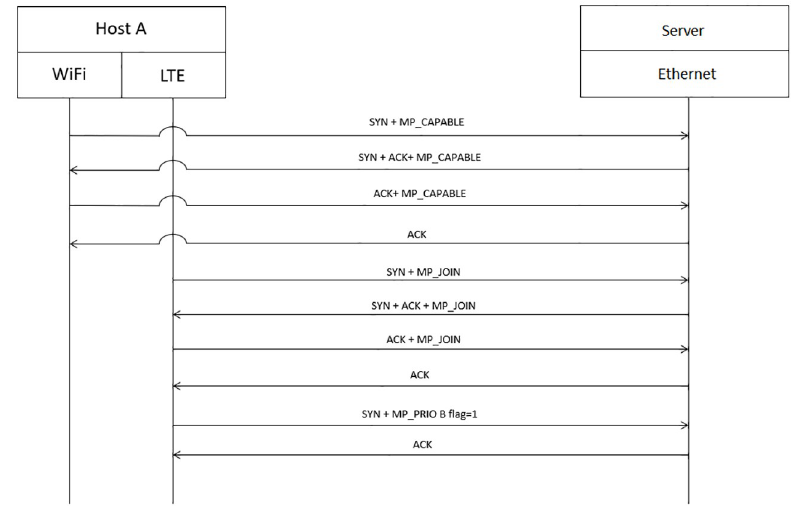
Fig 18. Seamless heterogeneous